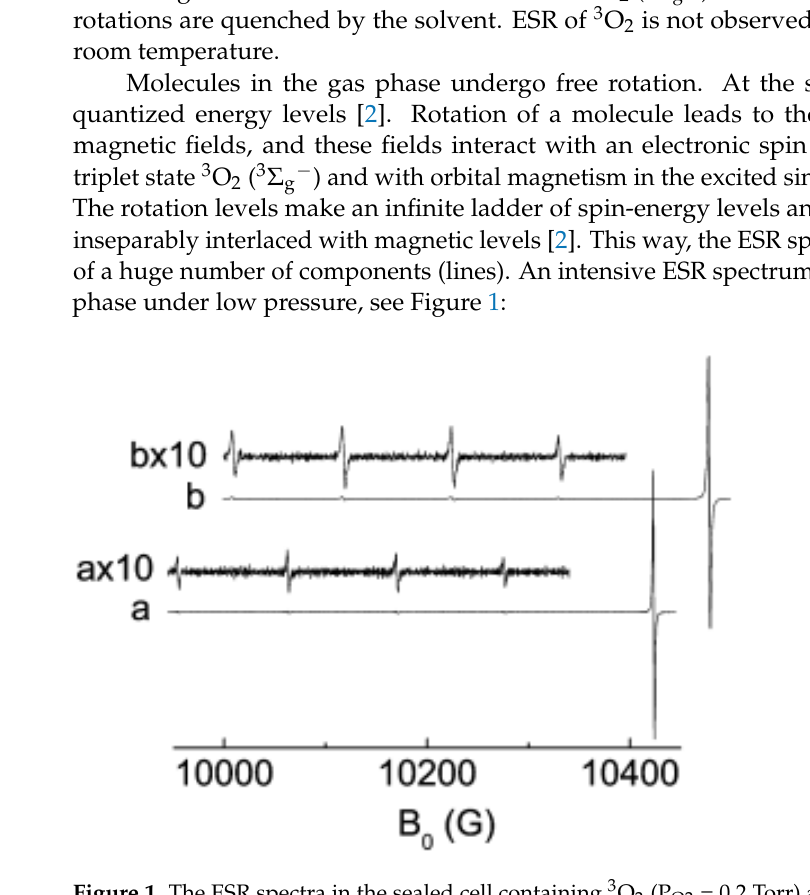
Table 1. The terms of O 2 and 2 NO in the ground and the closest in energy excited states as well as their paramagnetism in the gas and the liquid phases. Molecule Ground State Term